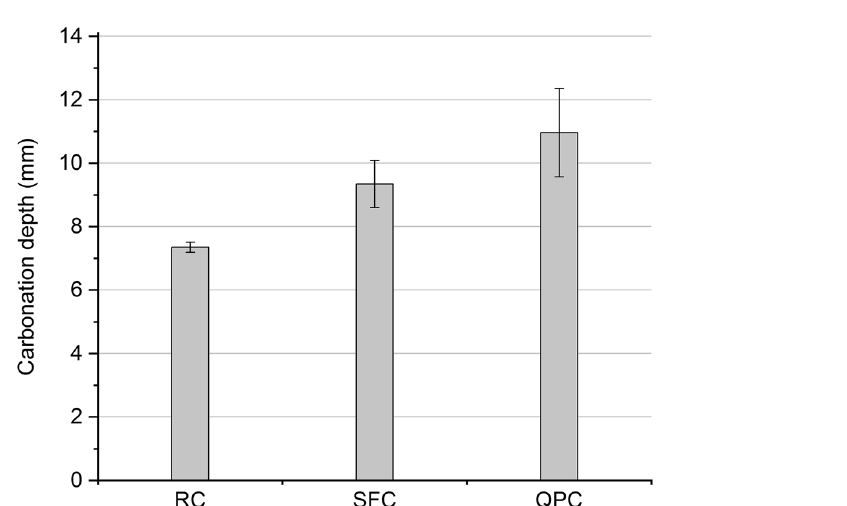
Figure 10. Accelerated carbonation depth of RC, SFC and